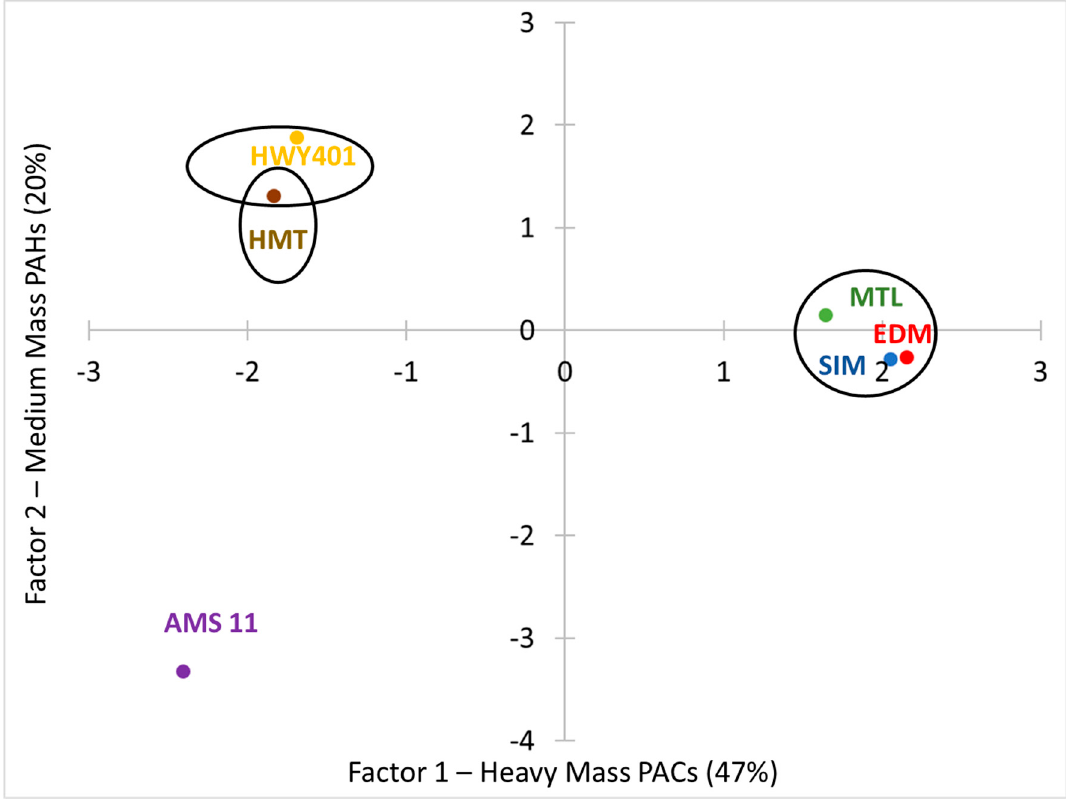
Figure 7. PCA projection of cases on the factor-plane for Factors 1 and 2 at the studied sites.